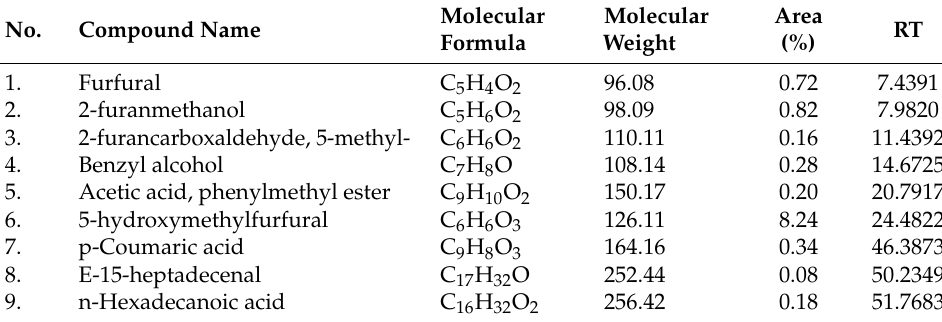
Table 3. Compounds identified in the aqueous extract of LM by